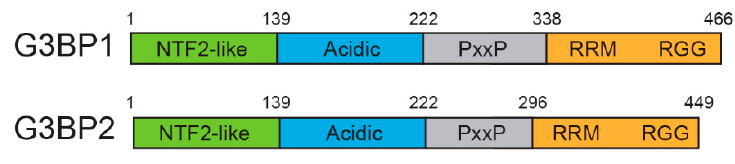
Figure 1. Domain architecture of G3BP1 and G3BP2.